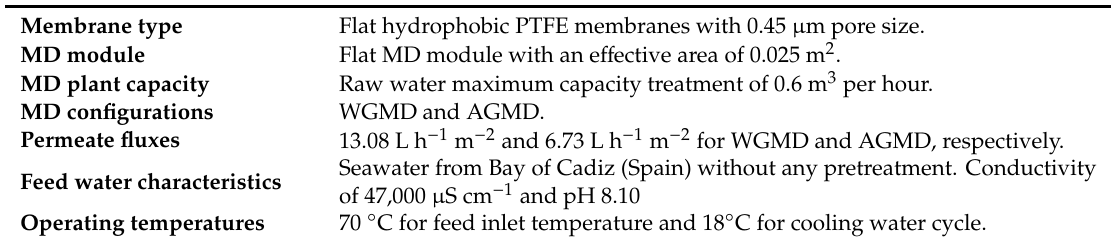
Table 2. MD laboratory system design and main operating conditions for seawater desalination